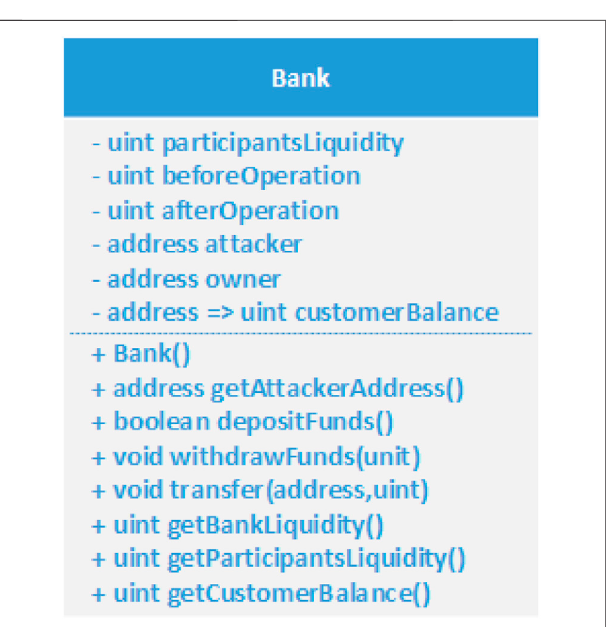
FIGURE 4 | UML class diagram example for the solution applied to a bank